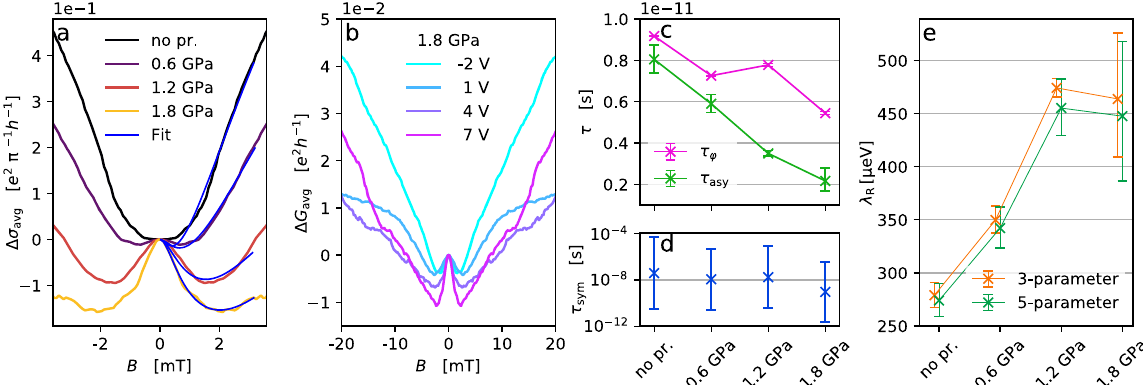
Fig. 4 Pressure-dependent SOC. a Comparison of averaged Δ σ avg ( B ) measurement curves for each pressure at 4 V. Clear signature of the WL → WAL evolution is visible. Solid blue lines for B > 0: fi ts using Eq. (1). b Two-terminal magnetoconductance for 1.8 GPa pressure at fi xed gate voltages with ±1.5 V averaging to reduce the effect of UCF, similarly to 3c. The WAL peak observed in a is present at all gate values with changing amplitude but the width staying approximately the same. At higher fi elds ( B > 5 mT) the in fl uence of UCF is still dominant. c Summary plot of the fi t values of τ φ , τ asy . The error bars represent uncertainty assessed by our method detailed in Supplementary Note 1. Decreasing τ asy with increasing pressure indicates the presence of an increasing Rashba SOC and interlayer coupling strength between graphene and WSe 2 . d Fit values of τ m . Due to the large uncertainty, the value of this parameter cannot be extracted. e λ R parameter for each pressure, calculated using the previously extracted parameter values for τ asy and τ m . Calculated values based on the three-parameter formula (Eq. (1)) are plotted with orange, and values based on the fi ve-parameter formula are plotted with green (see the Supplementary Note 1 for details). A clear growing tendency proves the enhancement of the proximity SOC induced by the WSe 2 layer. The data points are slightly shifted horizontally to avoid overlapping error bars.